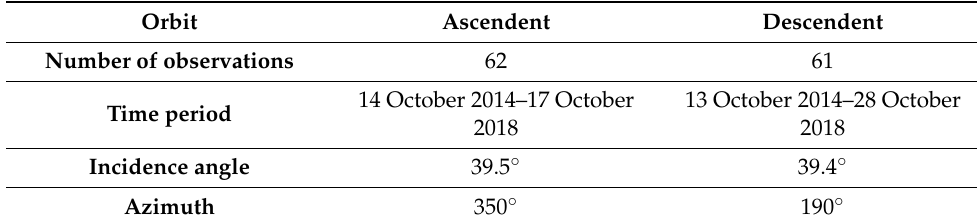
Table 2. Sentinel-1B images